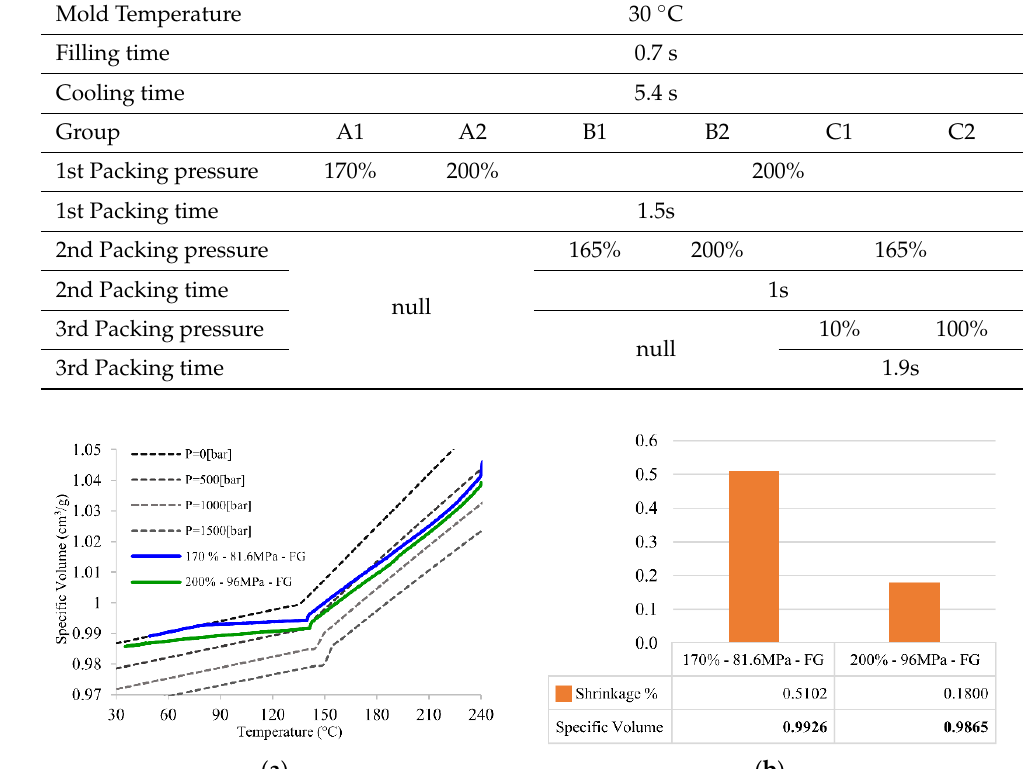
Table 2. Experimental parameters for packing pressure determination.